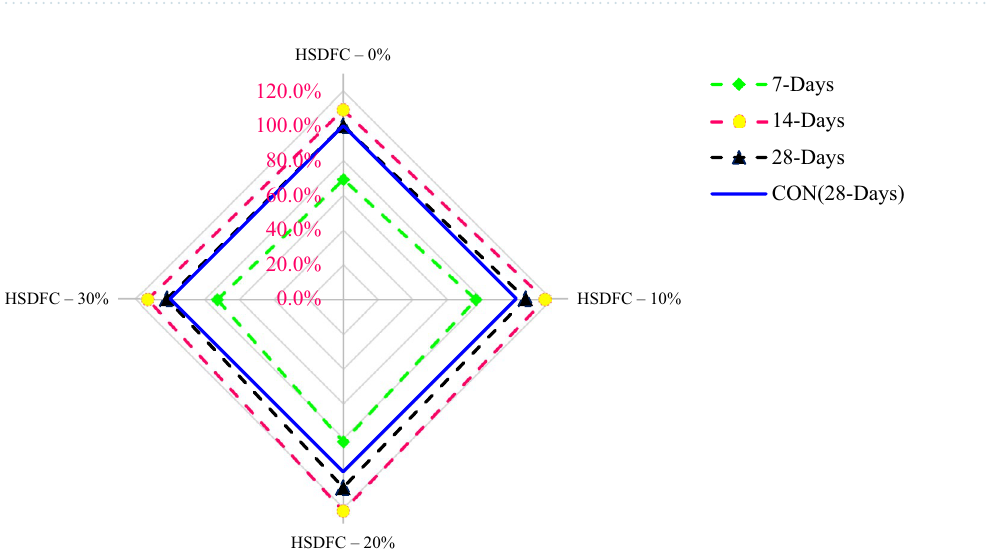
Figure 4. Compressive strength.